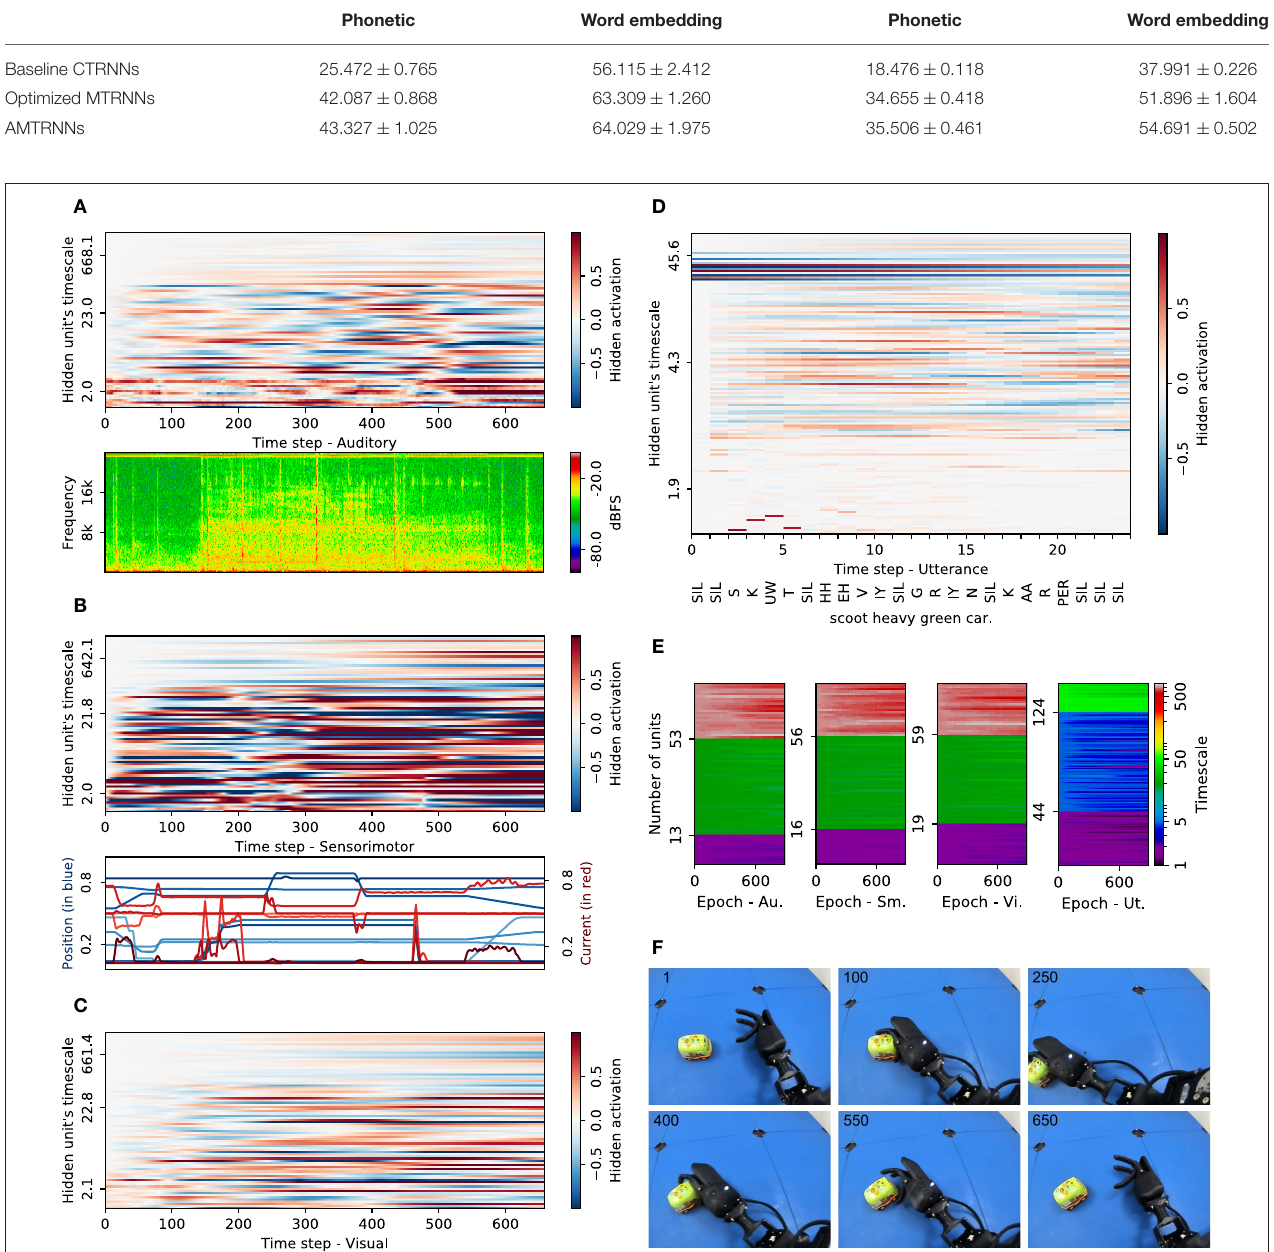
FIGURE 3 | Impact of adaptive timescales in processing crossmodal input and phonetic output sequences on a representative example: “ scoot heavy green car .” Hidden activations of all AMTRNN layers (stacked for each modality and sorted by timescale value) are shown together with the respective input or production. For the visual input, six frames are shown for selected time steps. (A) Auditory adaptive MTRNN and input. (B) Sensorimotor adaptive MTRNN and input. (C) Visual adaptive MTRNN. (D) Phonetic production adaptive MTRNN. (E) Timescale development during training. (F) Visual input (exemplary